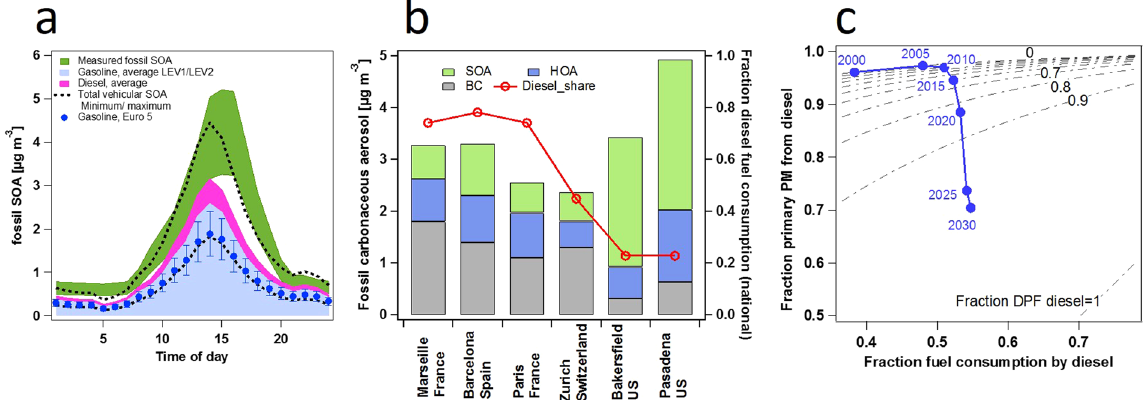
Figure 5. Estimates of the contribution of diesel and gasoline passenger cars to ambient urban PM and carbonaceous aerosol. ( a ) Contributions of gasoline (blue, shaded) and diesel cars (pink, shaded) to fossil SOA (green, shaded) in the L.A. basin, incorporating ambient OH exposure measurements, chamber SOA yields for LEV1/LEV2 vehicles, and ambient tracer concentrations (see SI for methodology). Maxima-minima for total vehicular SOA given by black dashed lines. Blue markers show an estimate from Euro 5 yields for comparison. Uncertainties in OH exposures are unaccounted for, possibly explaining the time shift between model/observed peak concentrations. For the measured fossil SOA, the range is determined by propagating the best estimate of the errors in the determination of SOA from Hayes et al . 26 and those related in the determination of SOA fossil fraction from 14 C measurements in Zotter et al . 27 . ( b ) Black carbon (BC), hydrocarbon-like organic aerosol (HOA) and fossil-fuel related (f) SOA and national share of diesel on-road vehicles (all types) according to the GAINS model 39 . The composition of the fossil carbonaceous matter in Europe and the US is clearly different, with the dominance of BC from diesel emissions in Europe and of fossil SOA from gasoline emissions in the US consistent with bottom-up calculations. ( c ) Fractional contribution of diesel passenger cars to primary